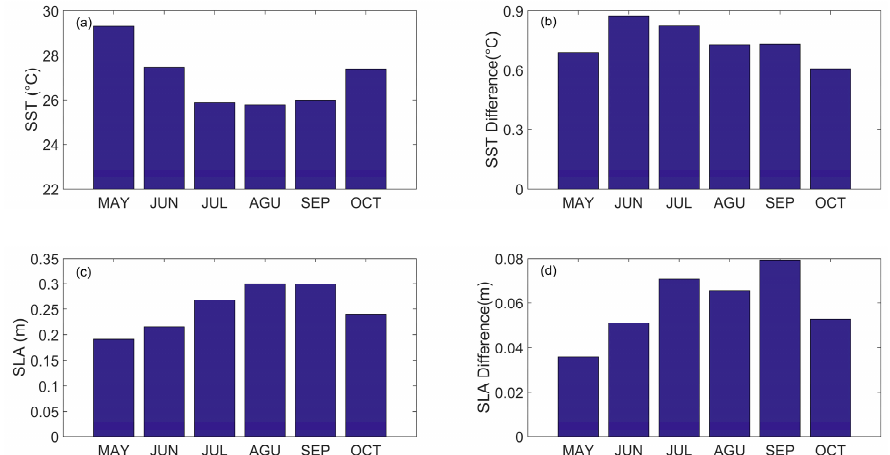
Figure 4. Monthly mean of ( a ) SST (unit: ◦ C), ( b ) SST anomaly (unit: ◦ C), ( c ) SLA (unit: m) and ( d ) SLA anomaly (unit: m) from May to October.